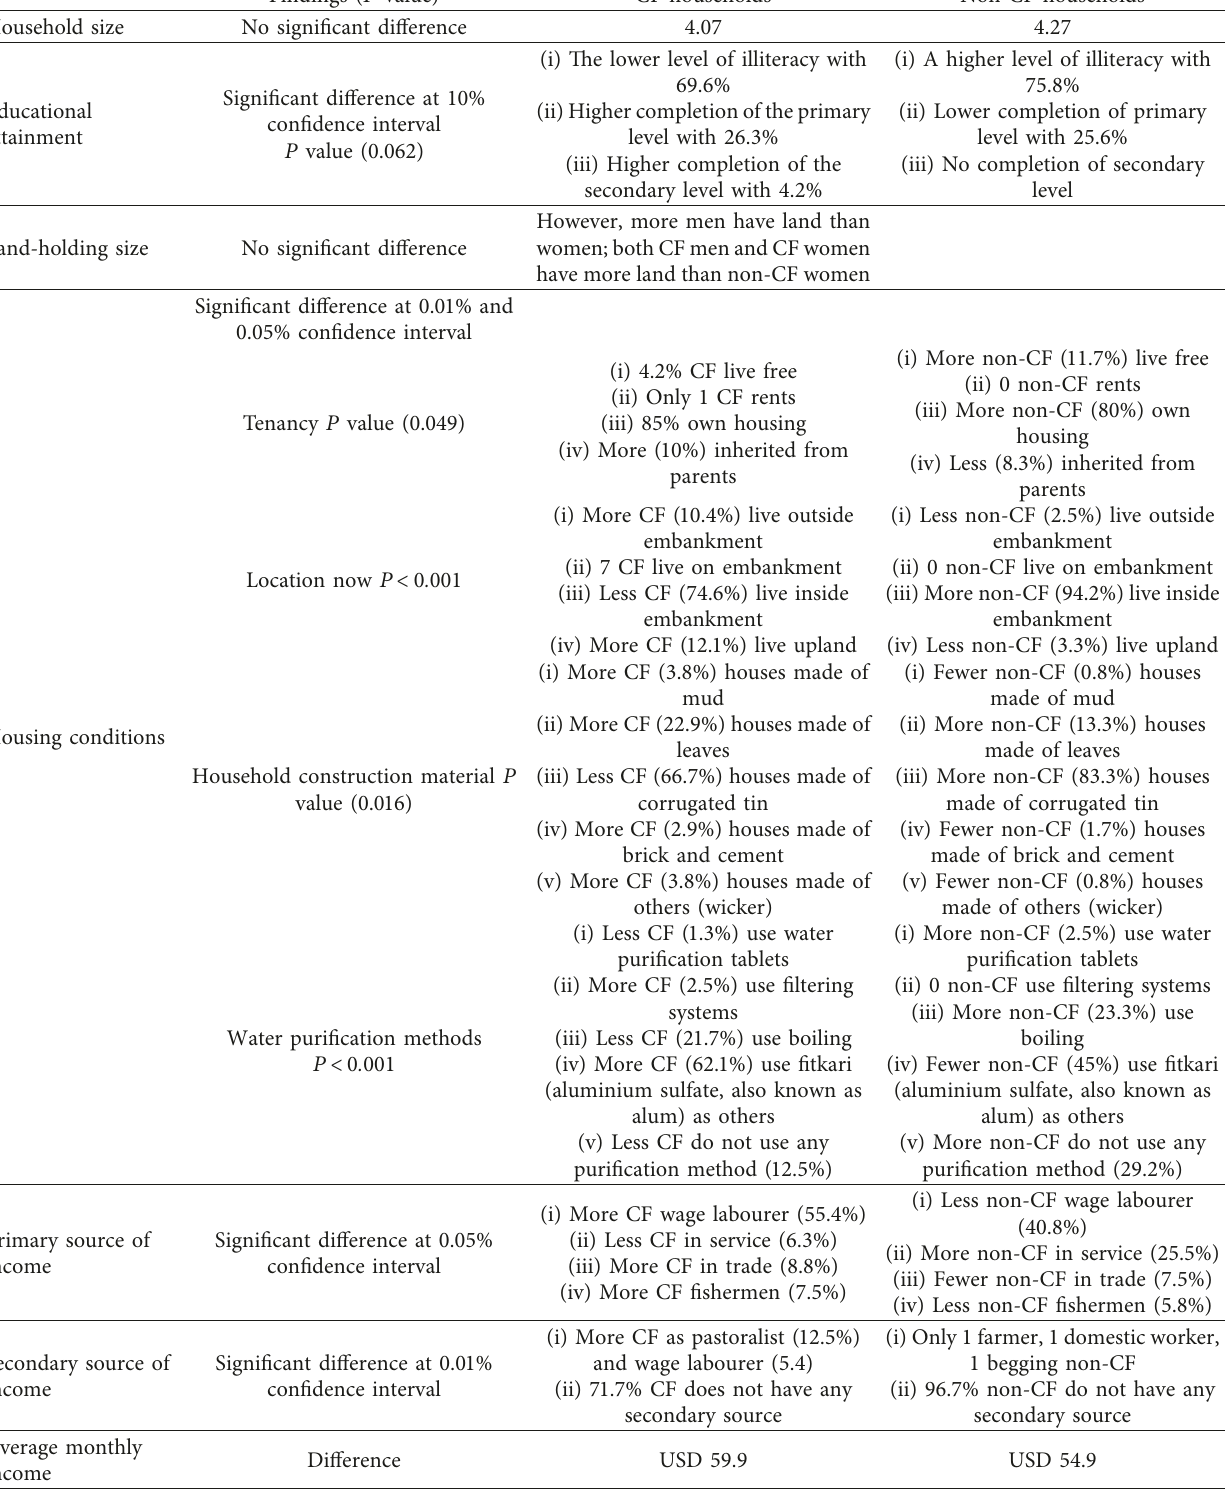
Table 3: Summary of differences in socioeconomic profiles of climate finance (CF HHs) and nonclimate finance households (non-CF